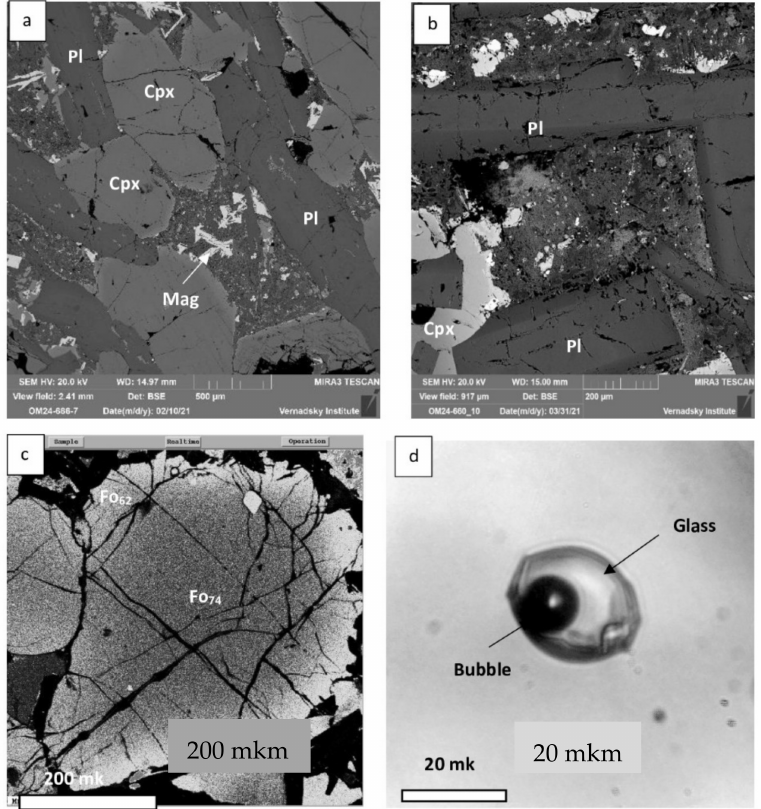
Figure 14. Rocks and minerals from the contact zones of the Norilsk intrusions evidence the rapid crystallization of the parental magma. ( a , b ) contact gabbro–dolerites; ( c ) zoned olivine, and ( d ) glass inclusion in olivine. Pl: plagioclase; Cpx: clinopyroxene; Mag: magnetite; Fo: mol.% forsterite in